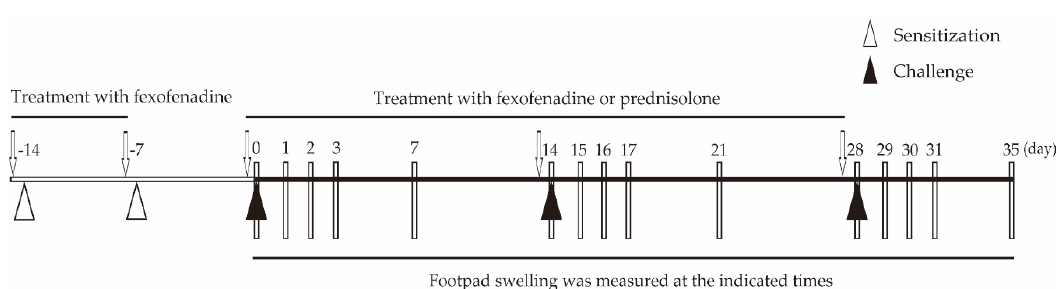
Figure 3. Macroscopic findings in Pd-induced ACD mice administered fexofenadine or prednisolone. Photographs show footpad swelling of a representative mouse at 7 d after the last challenge of Pd. In comparison with the footpad of Pd allergy mice, in terms of the redness and swelling, the feet of the groups A, B, C, and D showed decreases; in particular groups A and B showed dominant decreases.